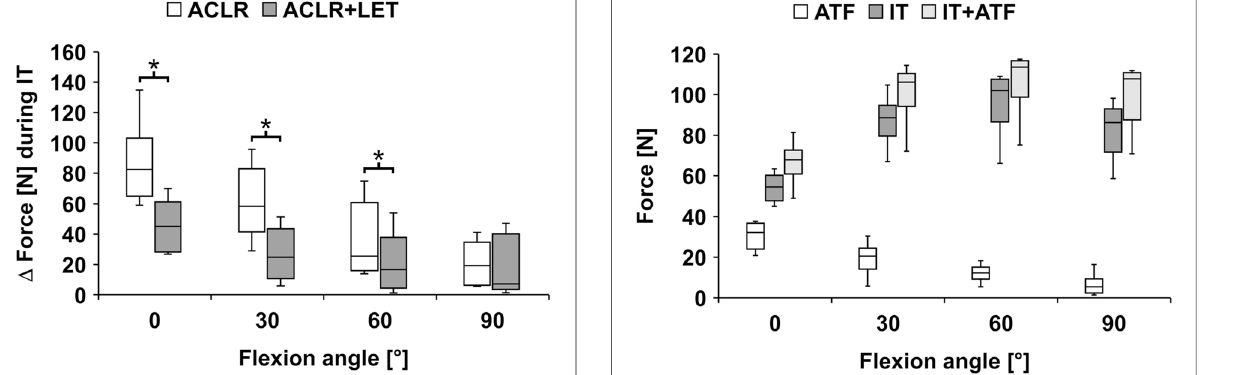
Fig. 6 Absolute graft forces in the lateral extra-articular tenodesis during the application of anterior tibial translation force (ATF), internal tibial torque (IT), and combined loading (IT +